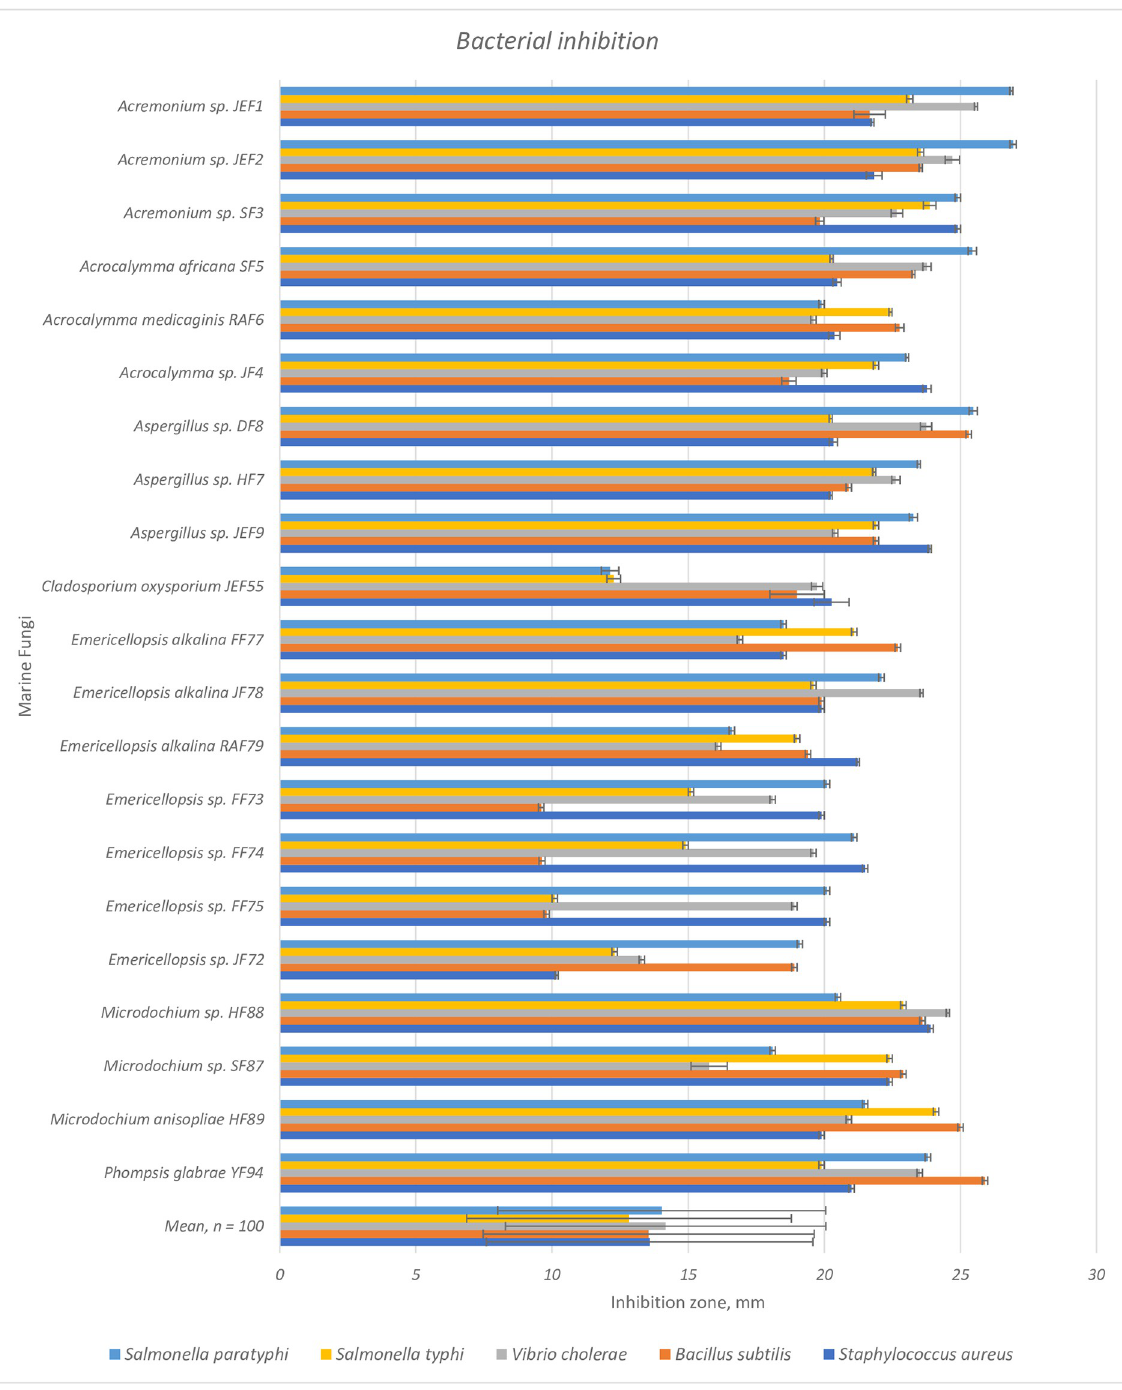
Fig 4. Inhibition (zone of inhibition, mean and error bar for SD) of five pathogenic bacteria (in colors) by the metabolites of the marine fungi isolated from the coasts of the Red Sea and the Arabian Gulf. Mean refers to the mean of all isolates tested. Letters after the species names refer to the isolate code in Table